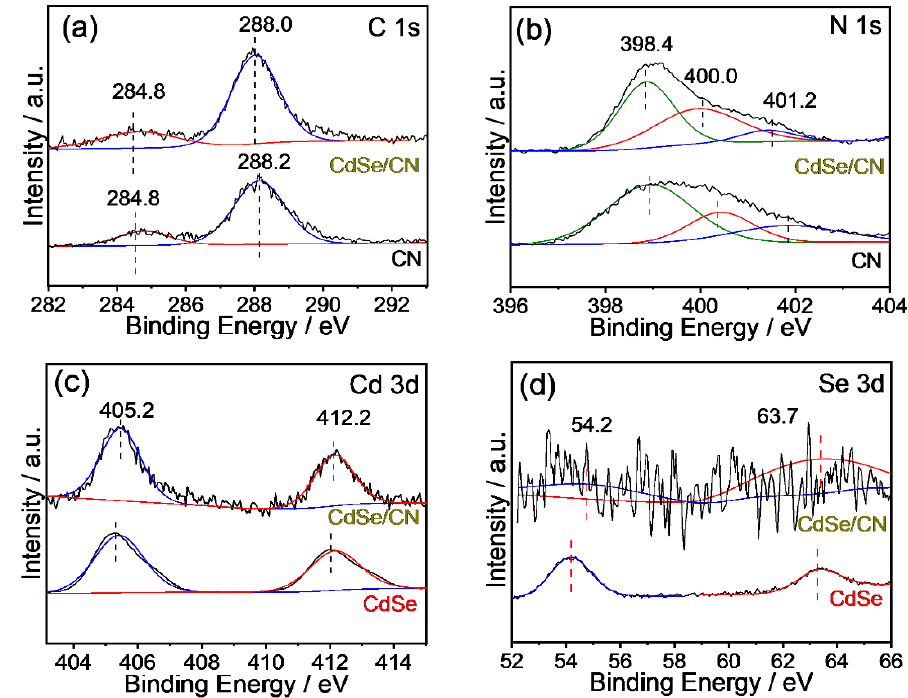
Figure 4. XPS spectra of 5% CdSe/CN: ( a ) C 1s, ( b ) N 1s, ( c ) Cd 3d, and ( d ) Se 3d.